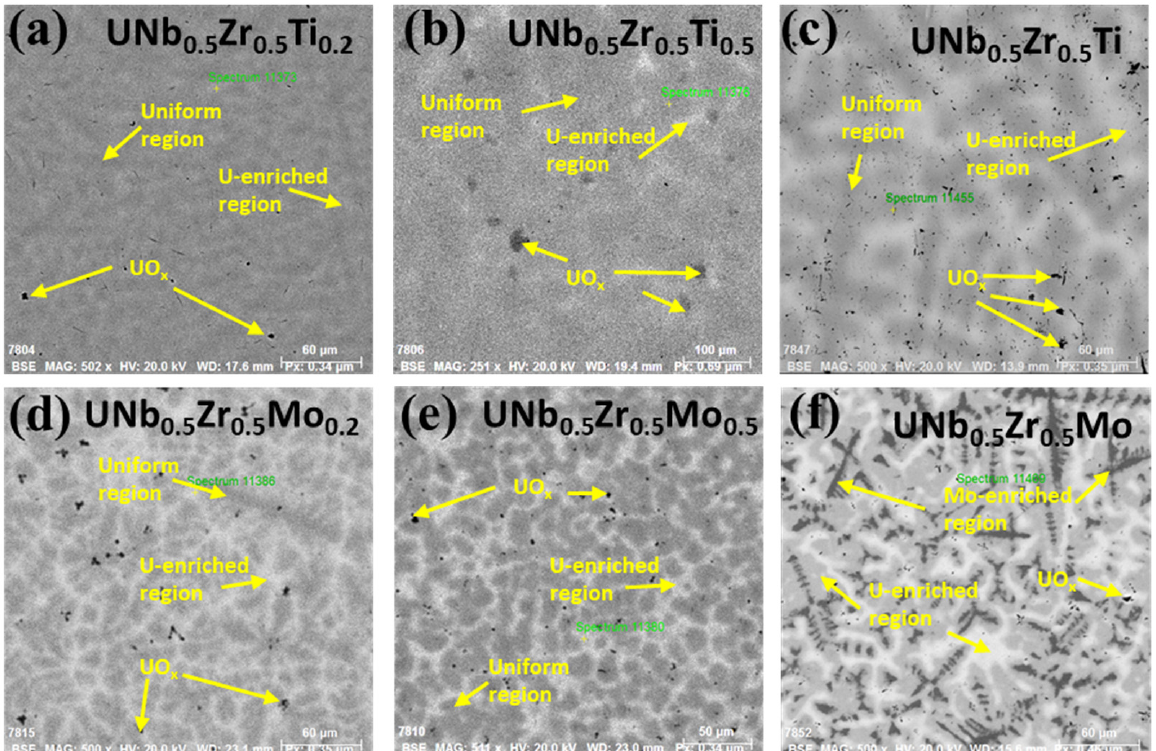
Figure 8. Microstructures of the UNb 0.5 Zr 0.5 -X (Ti/Mo) HEAs. ( a ) UNb 0.5 Zr 0.5 Ti 0.2 , ( b ) UNb 0.5 Zr 0.5 Ti 0.5 , ( c ) UNb 0.5 Zr 0.5 T, ( d ) UNb 0.5 Zr 0.5 Mo 0.2 , ( e ) UNb 0.5 Zr 0.5 Mo 0.5 , ( f ) UNb 0.5 Zr 0.5 Mo. Table 7. Hardness and strength of the UNb 0.5 Zr 0.5 -X HEAs.